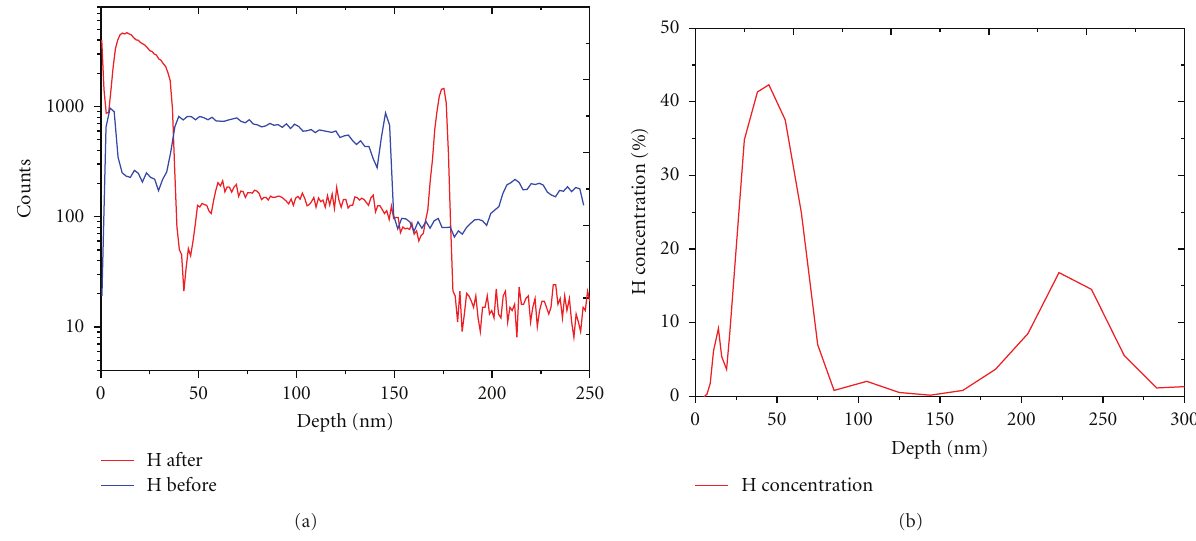
Figure 8: Hydrogen profiles for the sample Ti/TiO 2 /Ti/Si measured by SIMS (a) and by N-15